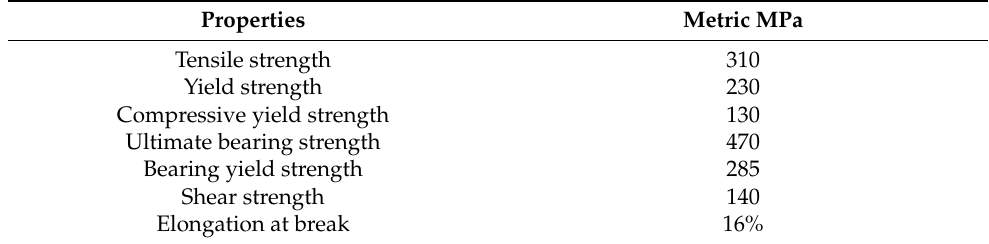
Table 2. Mechanical properties of AZ61 magnesium alloy.